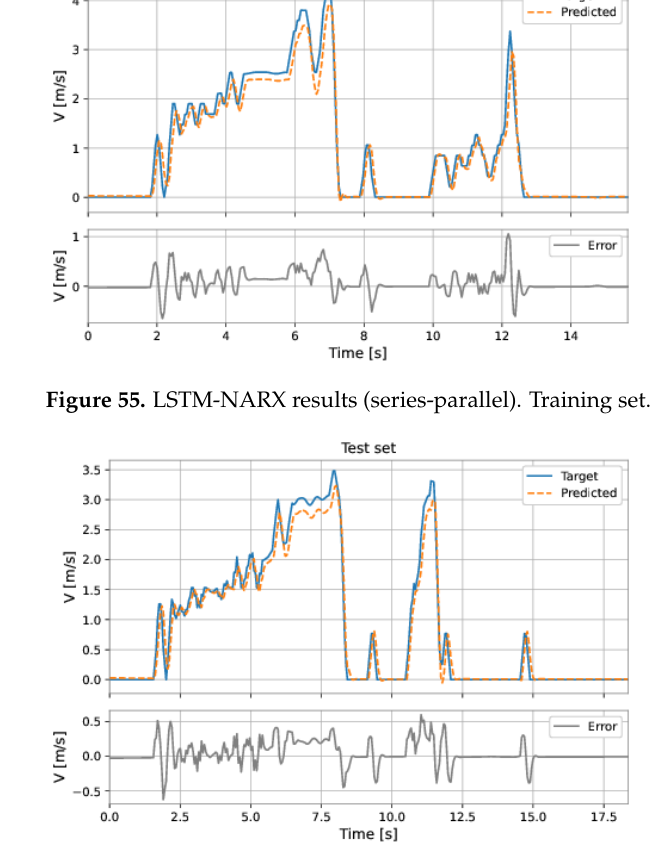
Figure 56. LSTM-NARX results (series-parallel). Test set.